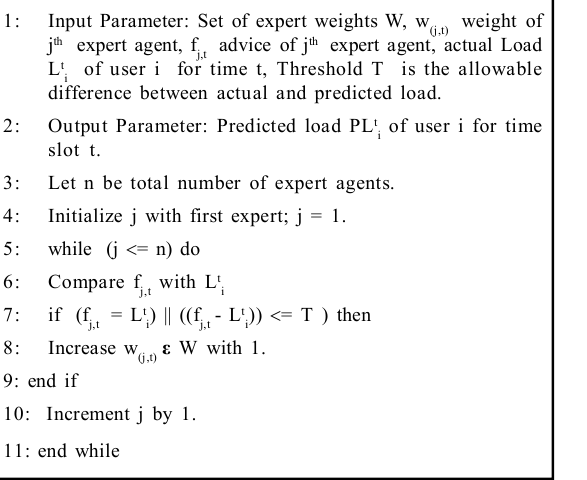
ALGORITHM-1: WEIGHTED AVERAGE PREDICTION